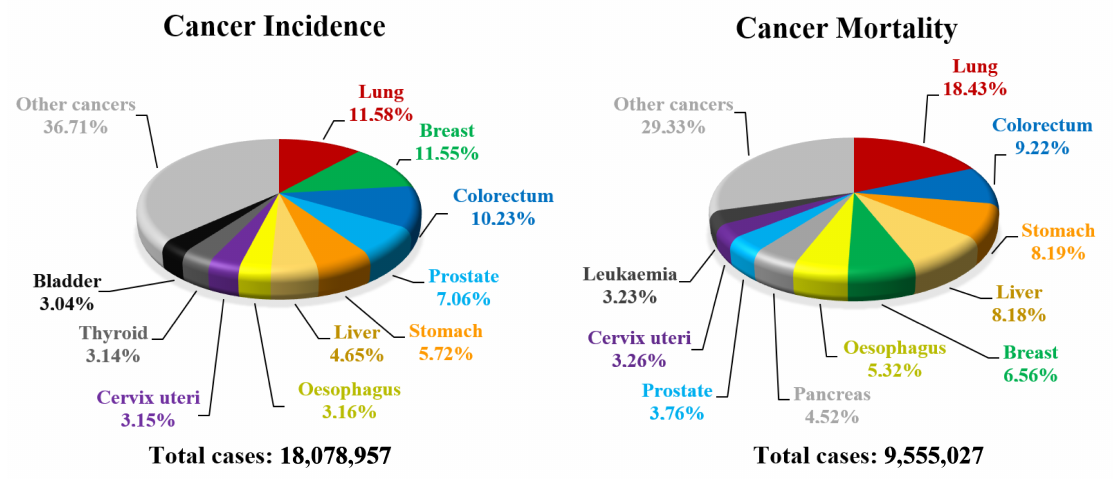
Figure 5. Estimated number of cancer incidences and cancer-related deaths in 2018.